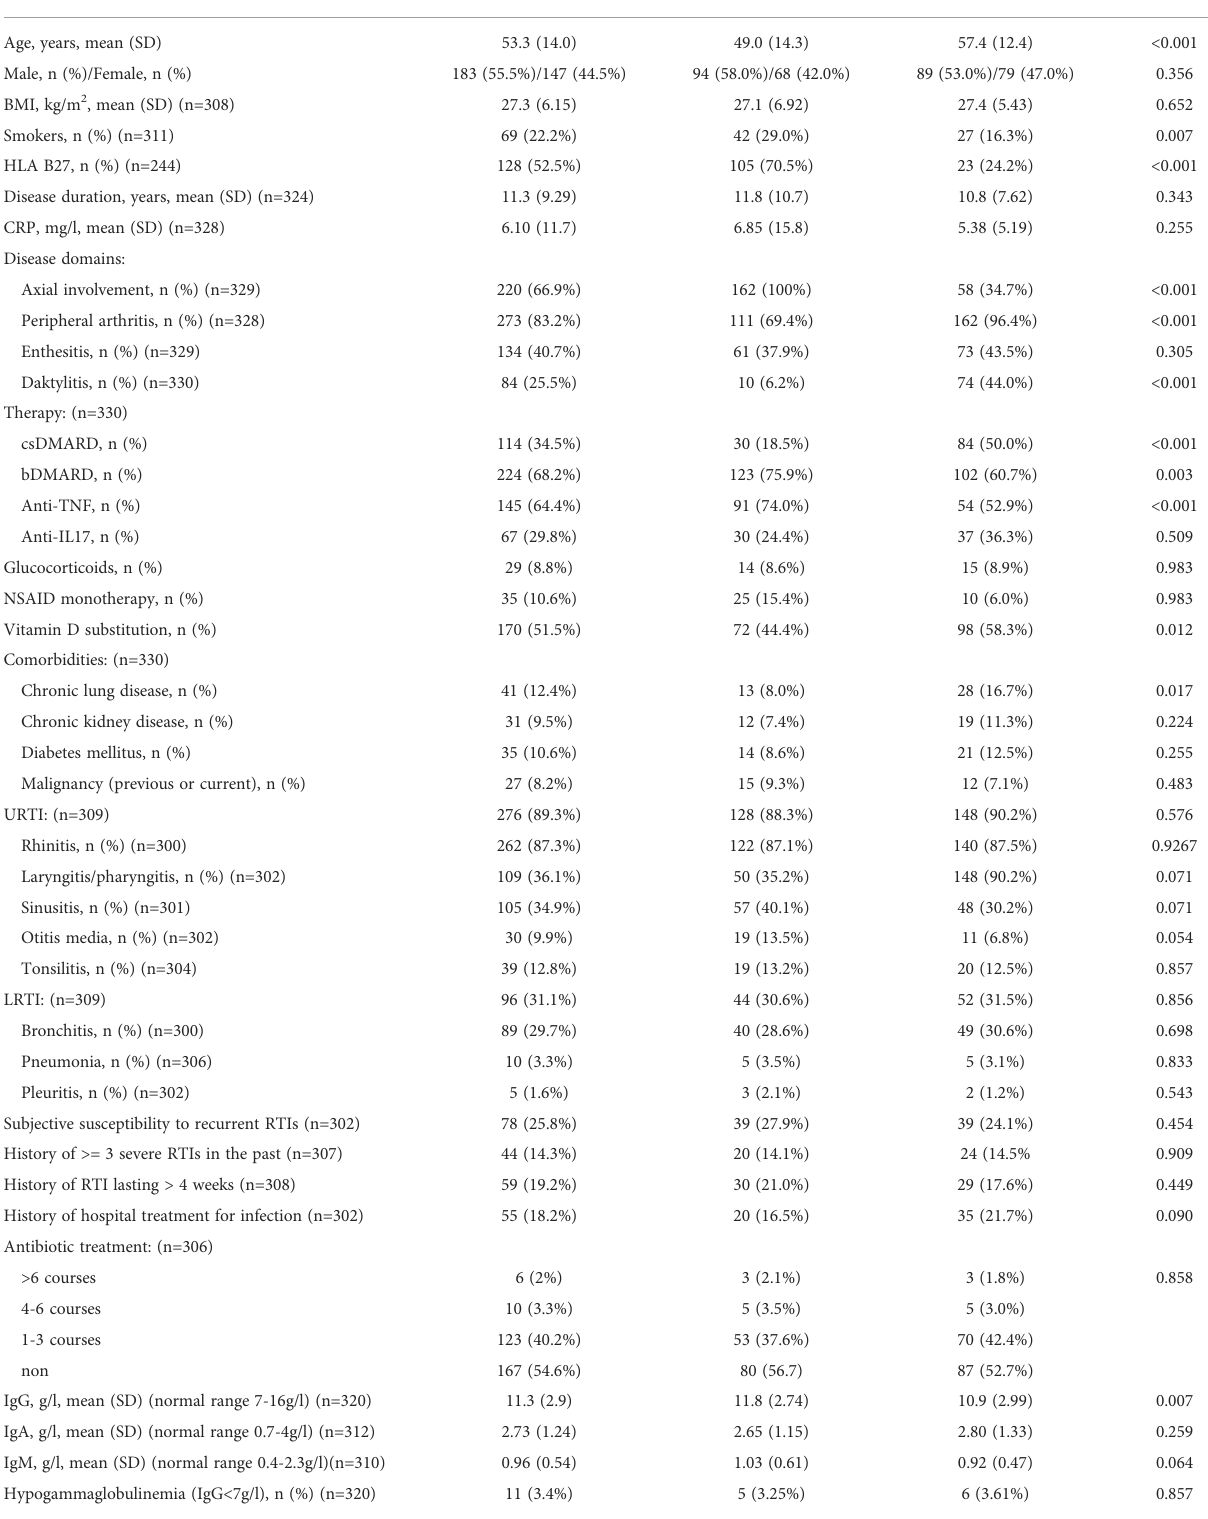
TABLE 1 Clinical description of patient cohort and frequency of